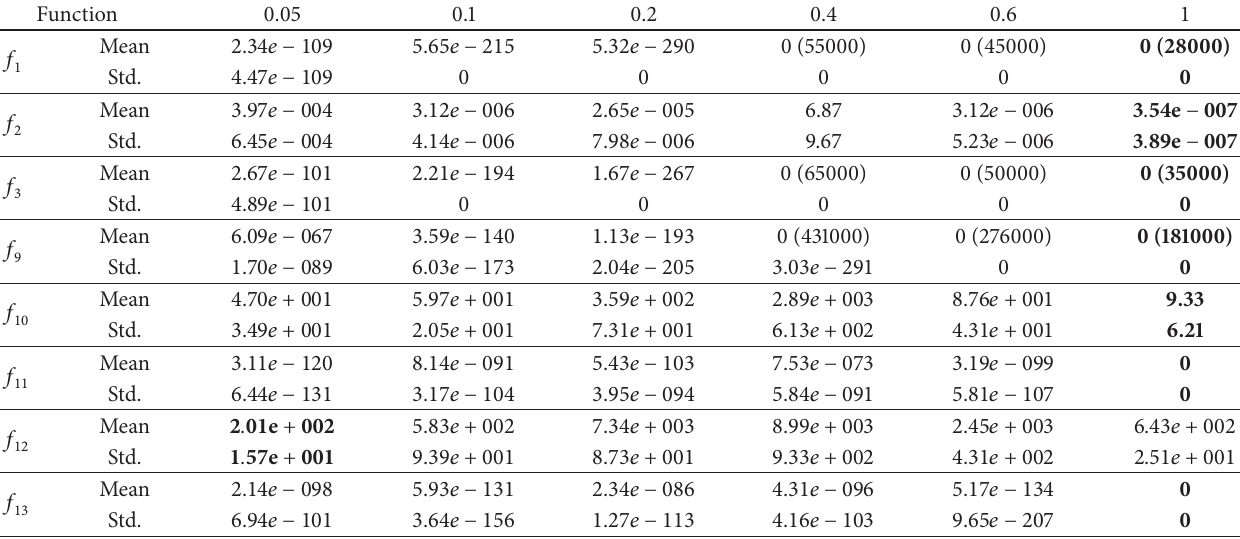
– f & f – f ) with different CRs. In bold are the best 1 3 9 13